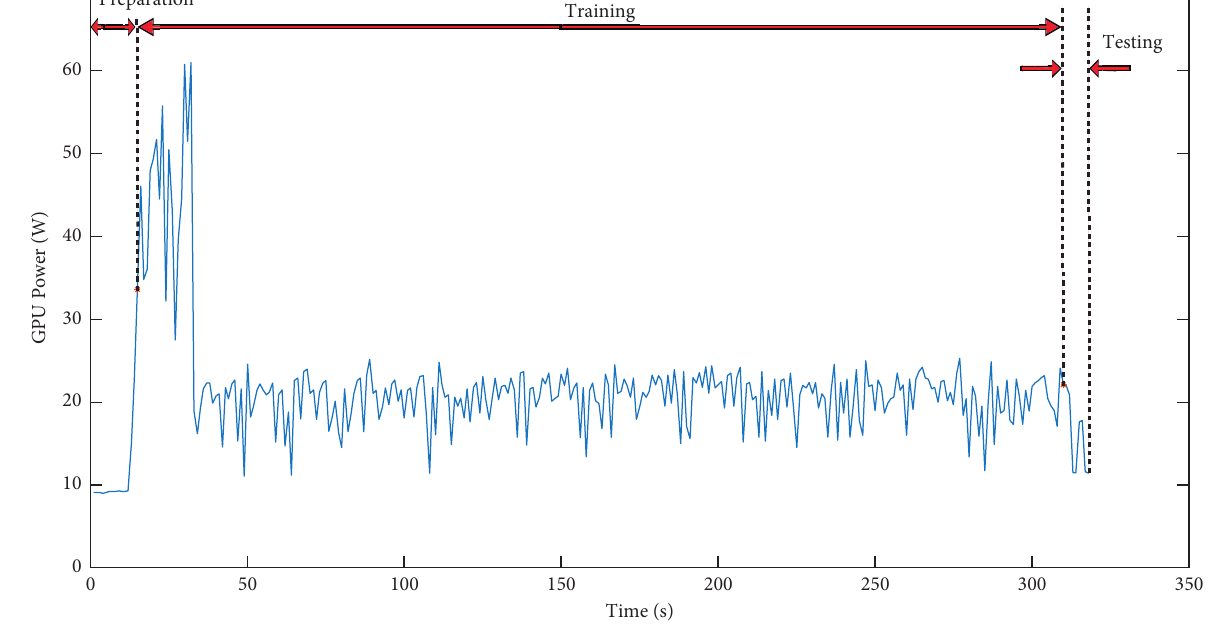
Figure 8: GPU power usage trend. Table 7: Metrics for evaluating GPU